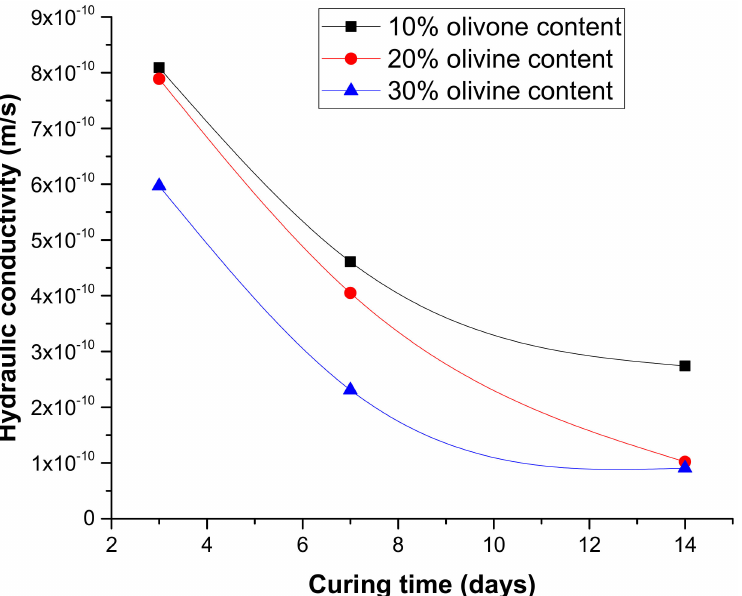
Figure 3. Hydraulic conductivity of the olivine-admixed clay at different curing durations (3, 7, and 14